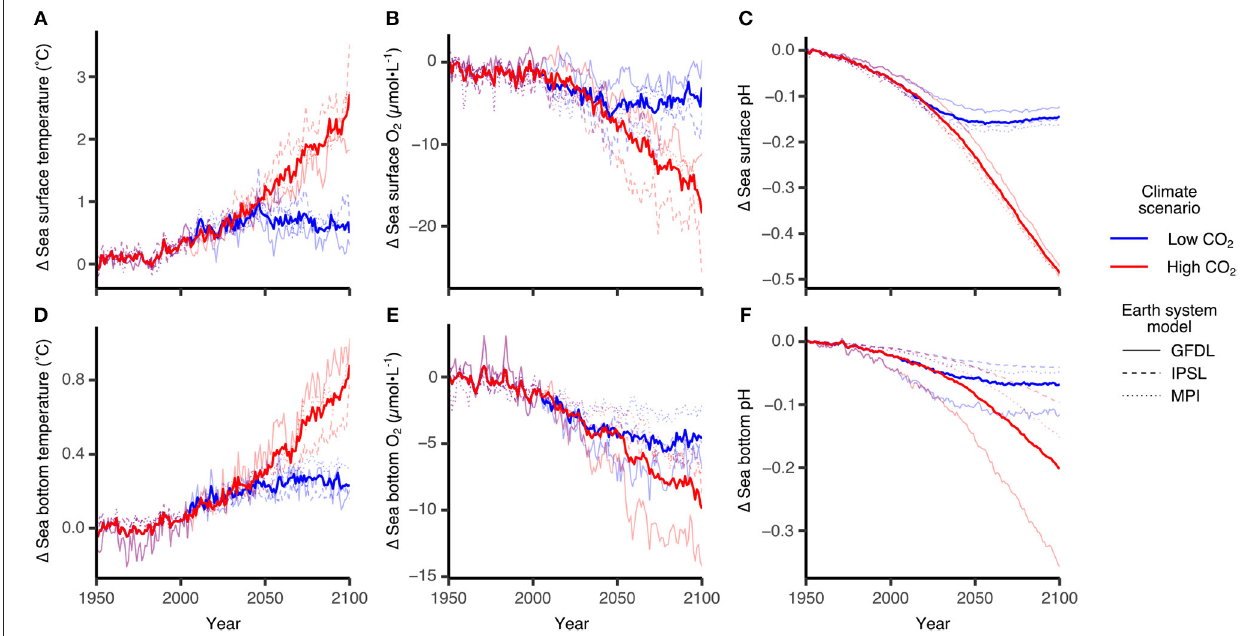
FIGURE 5 | Projected changes in sea surface and bottom ocean variables using three ESMs GFDL-ESM2G, IPSL-CM5A-MR and MPI-ESM-MR. Individual panels show changes in sea surface (A) temperature, (B) oxygen concentration and (C) pH and in bottom (D) temperature, (E) oxygen concentration and (F) pH. Bold lines represent multi-model averages and trajectories are relative to the 1951–1960 average. Blue lines are trajectories following climate scenarios where carbon emissions are mitigated and Paris Agreement targets are met (RCP2.6, +1.5 ◦ C global sea surface temperature), while red lines are climate scenarios along our current emissions trajectory (RCP8.5,+3.5 ◦ C). Reproduced from AMAP (2018) with permission from AMAP.